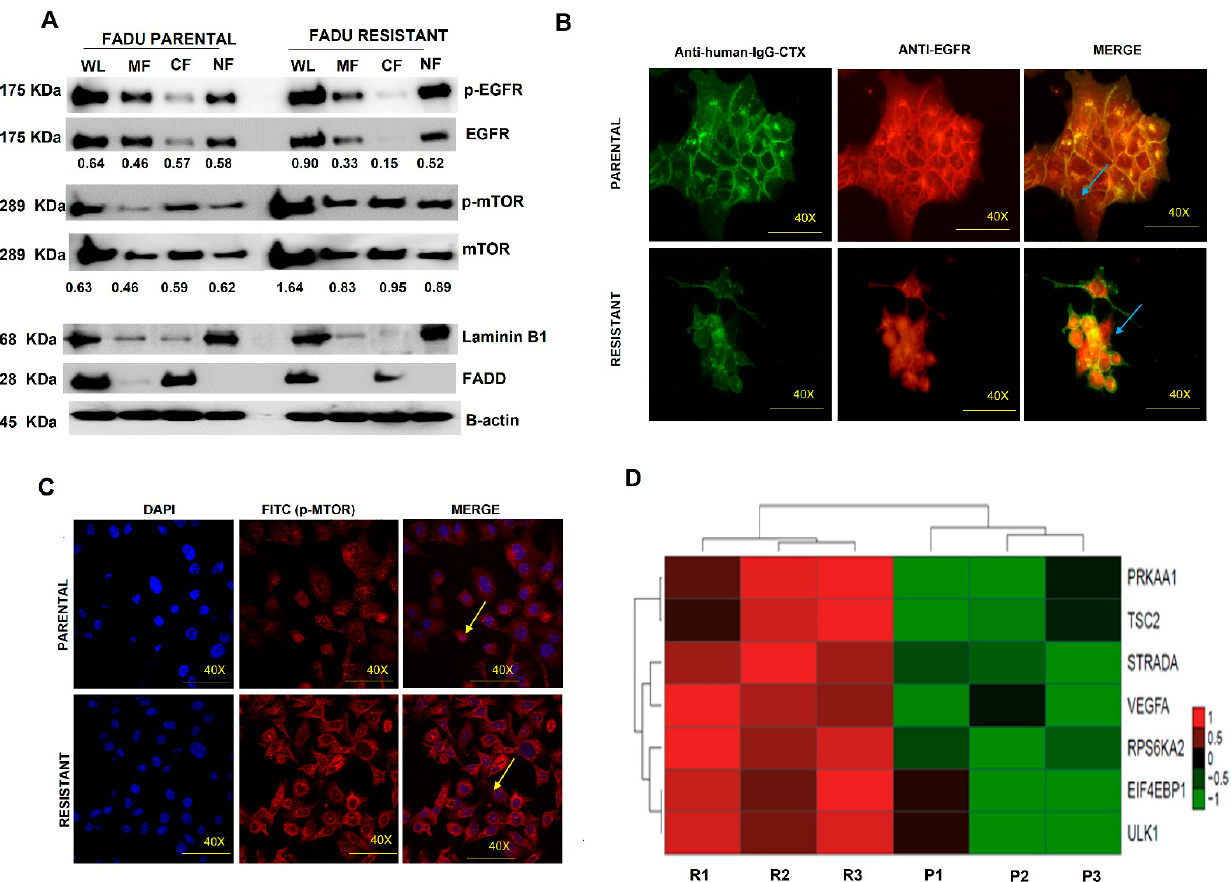
Figure 5. EGFR-FITC+ internalization and mTOR-FITC+ expression in FaDu parental and FaDu resistant cells. ( A ) Subcellular protein fractionation assay for EGFR detection in parental and resistant cells. ( B ) p-EGFR nuclear translocation in resistant cells by Immunofluorescence assay. ( C ) p-mTOR immunofluorescence assay in parental and resistant cells. ( D ) mTOR-related genes differentially expressed in FaDu parental and FaDu resistant by microarray of expression. DAPI (Hoescht) staining in blue. p-EGFR-FITC+ p-mTOR-FITC+. Arrows indicate EGFR-FITC+ and p-mTOR-FITC+ localization. The images were acquired in 40× magnification. The number under the bands represented relative ratios (phospho/total).